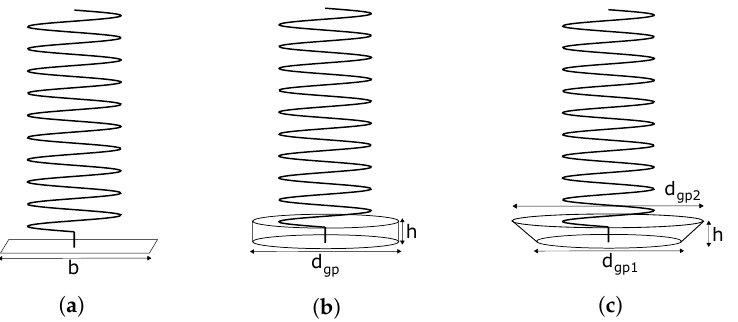
Figure 5. Ground plane models and dimension parameters. ( a ) Square GP. ( b ) Cylindrical GP. ( c ) Conical